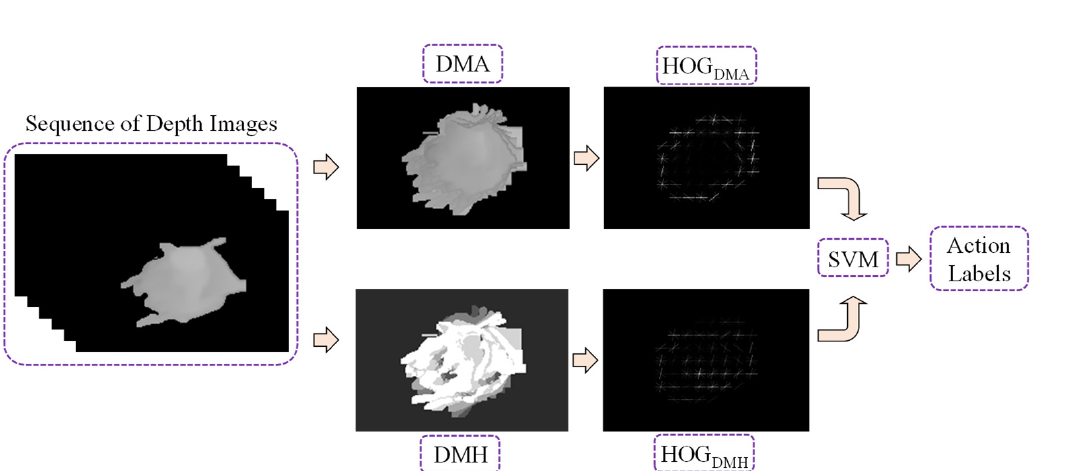
Figure 11. Normalization of person silhouette.